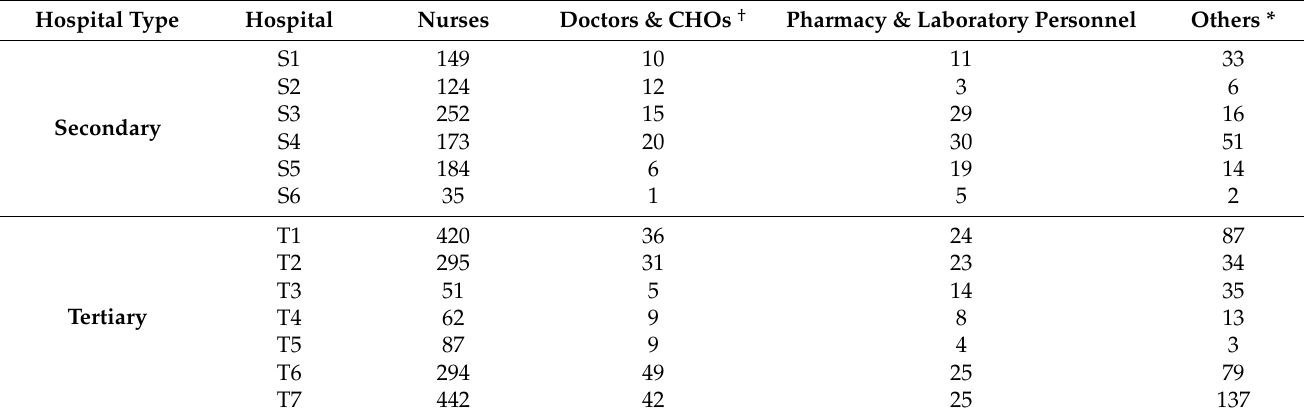
Table 3. Categories of healthcare workers in 13 public hospitals in the Western Area of Sierra Leone assessed on hand hygiene policy using the HHSAF in